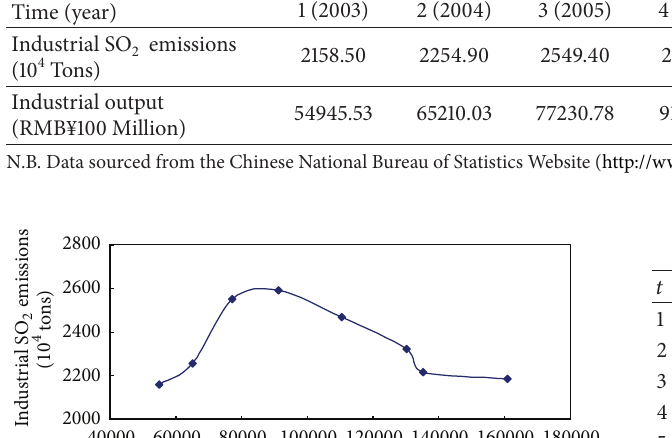
Table 1: China’s industrial SO